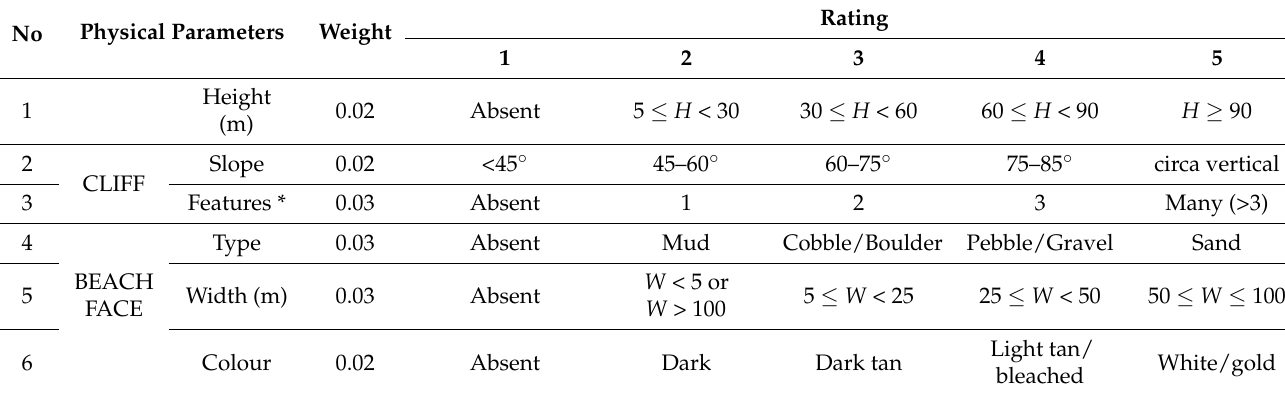
Table 1. Checklist parameters (CSES)